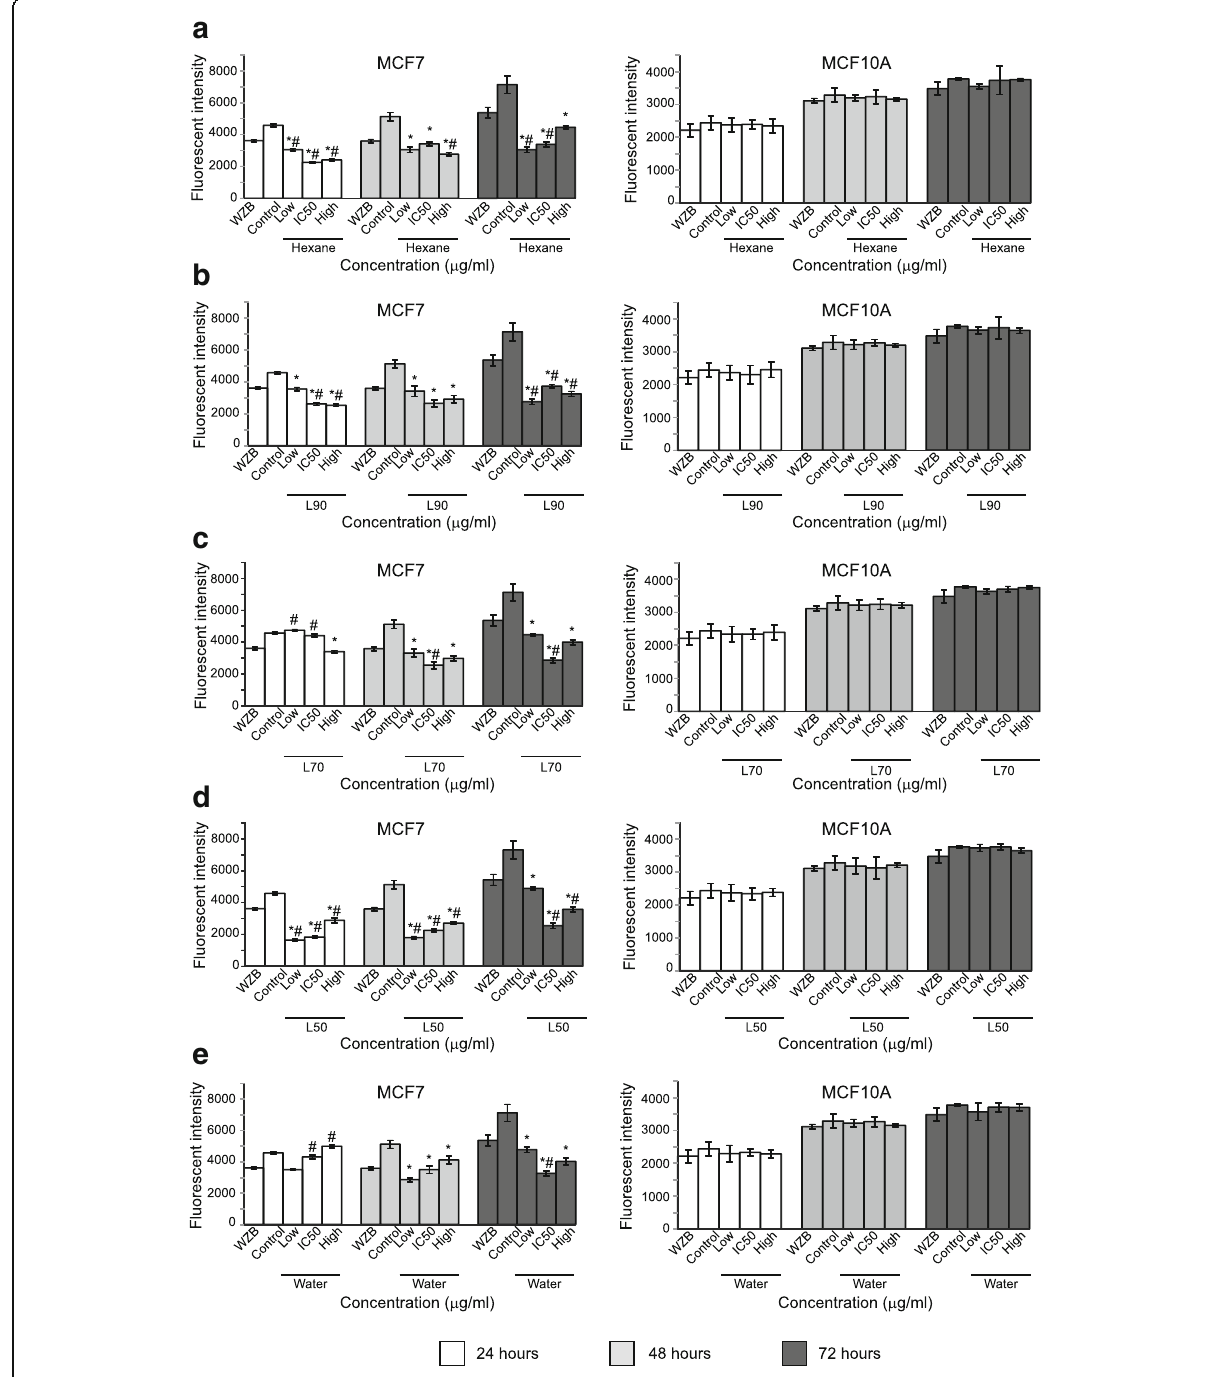
Fig. 4 Inhibition of glucose uptake of B. frutescens leaves extracts after 24, 48 and 72 h of incubation MCF-7 (left panels) or MCF10A (right panels) cells were either treated with DMSO vehicle control (control) or B. frutescens leaves extracts ( a ) hexane, b L90, c L70, d L50 or ( e ) water for 24, 48 and 72 h at three different concentrations; lower than IC 50 value (low), IC 50 value (IC 50 ) and higher than IC 50 value (high). WZB117 served as the positive control. Data is expressed as mean ± standard error mean based on four independent experiments with triplicate wells for each concentration. * p < 0.01, compared with control, # p < 0.01 compared with the positive control